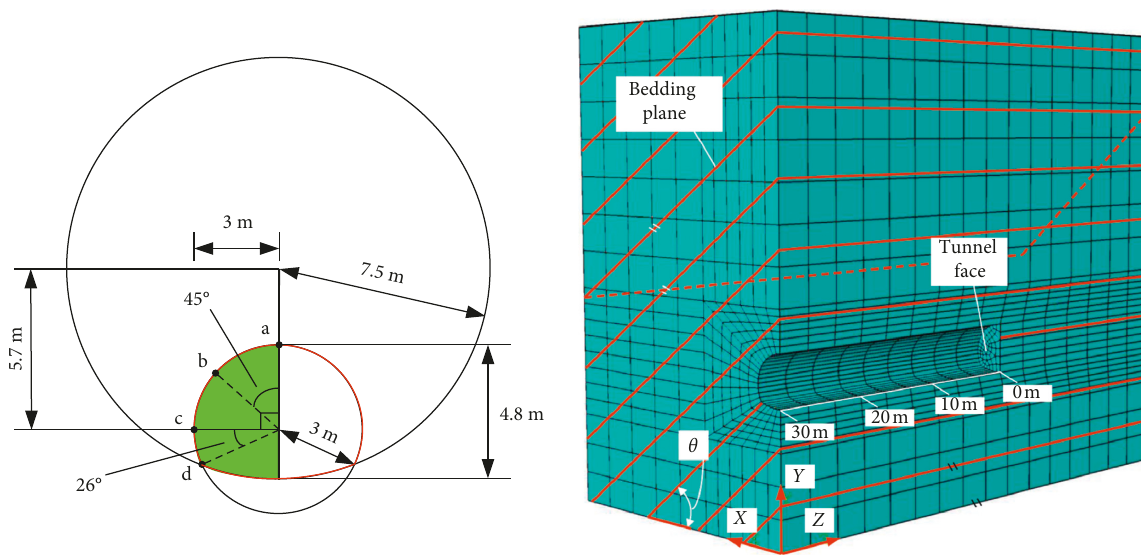
Figure 16: Schematic of shear strength